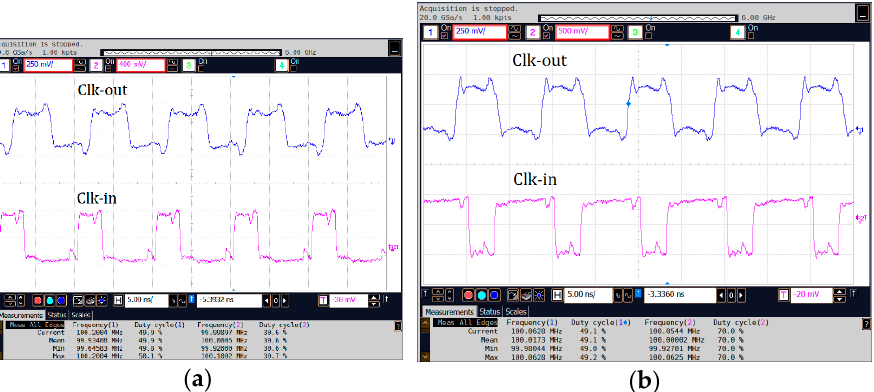
Figure 12. Measurement waveform of output clock for clock frequency of 100 MHz ( a ) input duty cycle of 30% ( b ) input duty cycle of 70%.